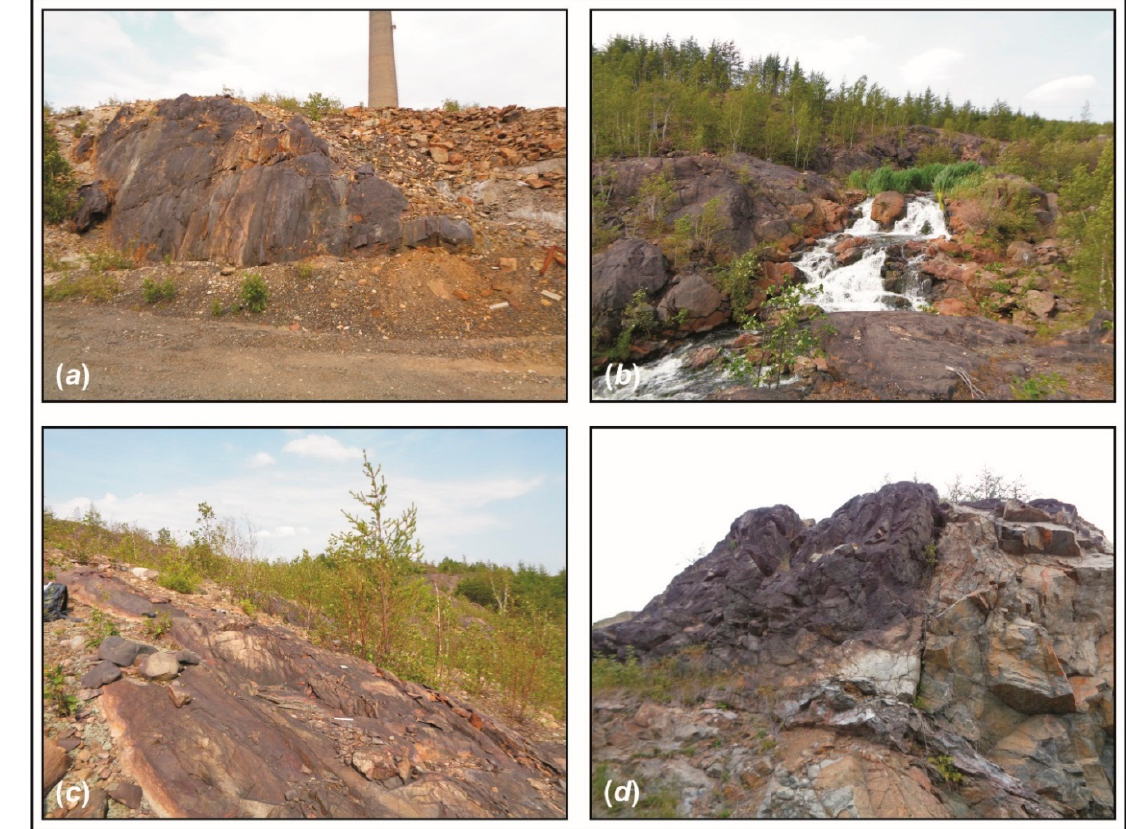
Figure 2. Examples of coated bedrock located in the Coniston study area: ( a ) Mississagi Formation, near the base of the south Coniston stack; ( b ) Grenville gneiss; ( c ) Mississagi Formation; ( d ) Nipissing Gabbro.